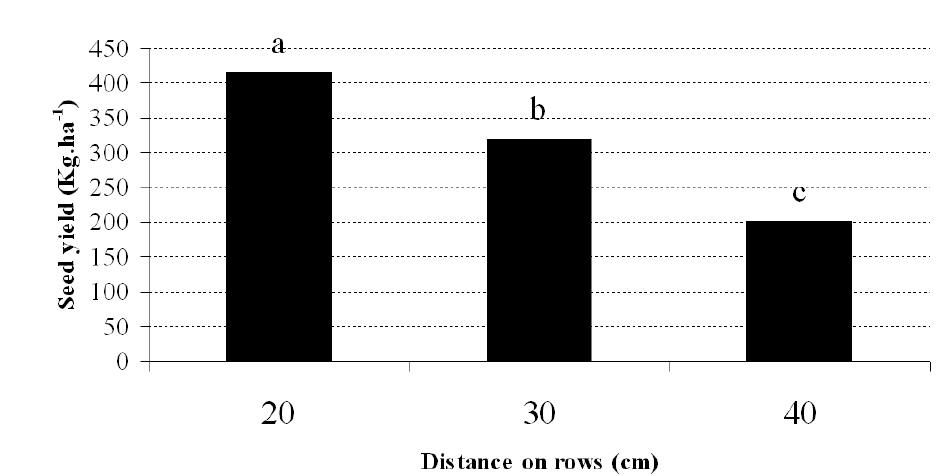
Fig. 3. Main effects of within row spacing on seed yield. All the values followed by the same letter in each column are not statistically different at the p<0.05 probability level